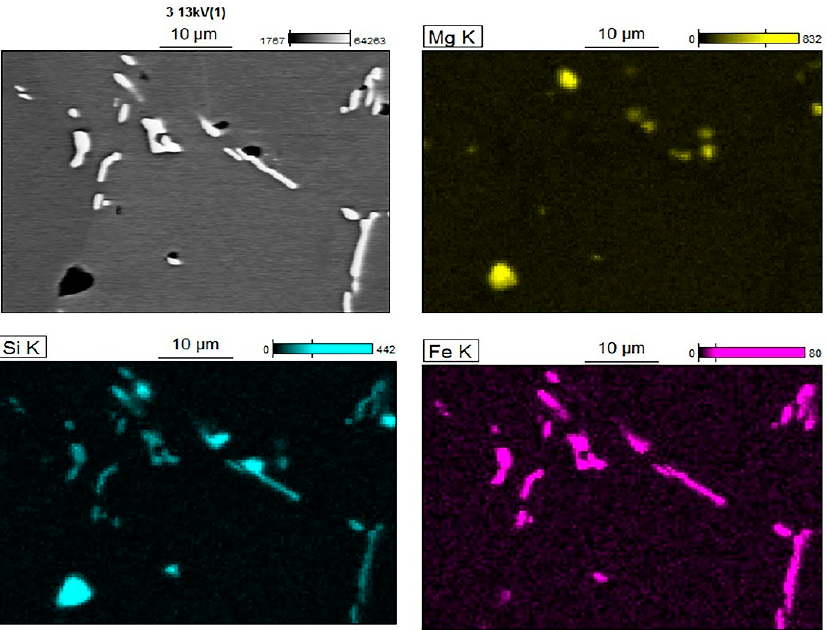
Figure 5. EDS analysis of the AlMg0.56Si0.56 wire rods after homogenization.